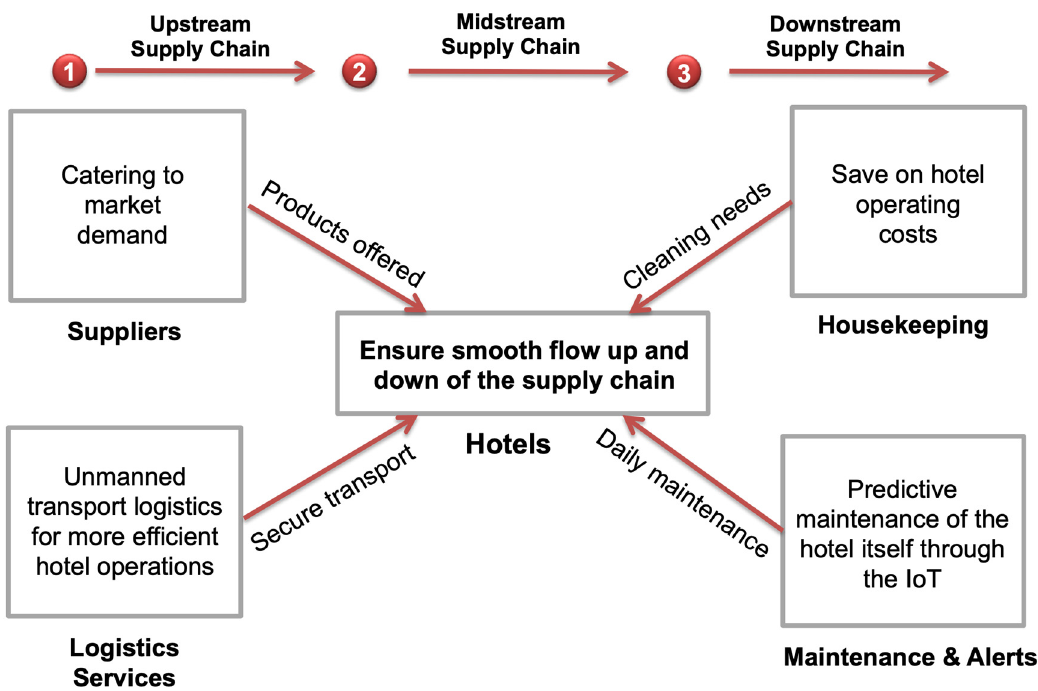
Figure 11. The use of the Internet of Things in the hotel supply chain.